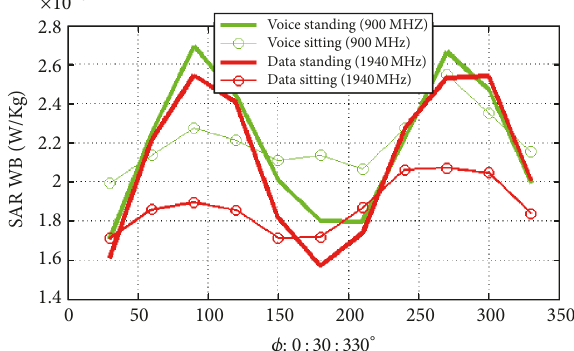
induced in voice and WB